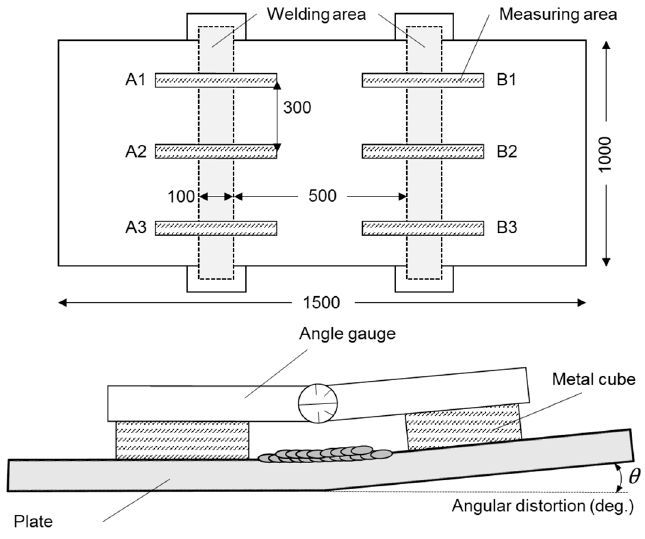
Figure 2. Bead-on-plate welding and measurement (unit: millimeters) [10]. Table 1. Welding conditions for bead-on-plate welding experiment.